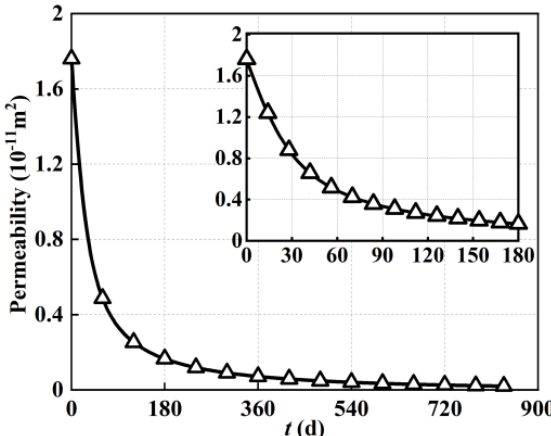
Figure 8. The variation in porous anode electrode permeability over the operating time during 20,000 h of steady − state operation.